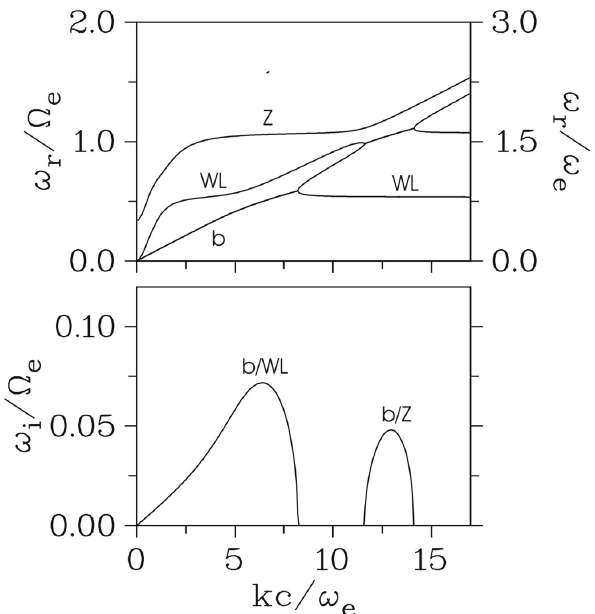
Fig. 8. Excitation of both modes, the whistler-Langmuir mode and the Z-mode ( G = 1 . 5, θ = 30 ◦ ) , by an electron beam with param- eters n b / n o = 0 . 01, V b /c = 0 . 15. The notations “b/WL” and “b/Z” should indicate the different origins of both instabilities.